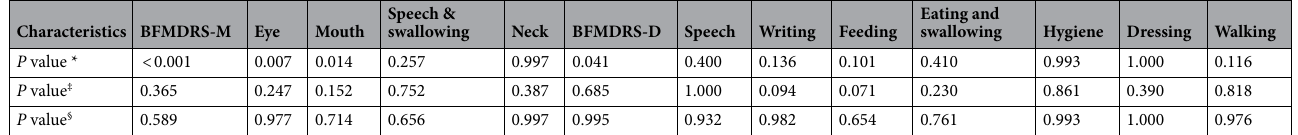
Table 4. Two factors ANOVA results in Primary Outcome (factors; time and group). *Statistically analyzed using two factors ANOVA (factors; time). ‡ statistically analyzed using two factors ANOVA (factors; group). § statistically analyzed using two factors ANOVA (factors; time*group).